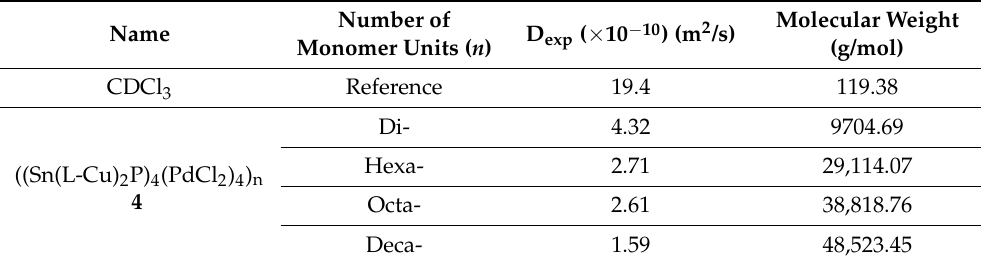
Table 4. Summary results of DOSY NMR experiments, the molecular weight and the diffusion coeffi- cient values for the research object 4 . The molecular weight and diffusion coefficient of deuterium chloroform (CDCl 3 ) are used as reference in the